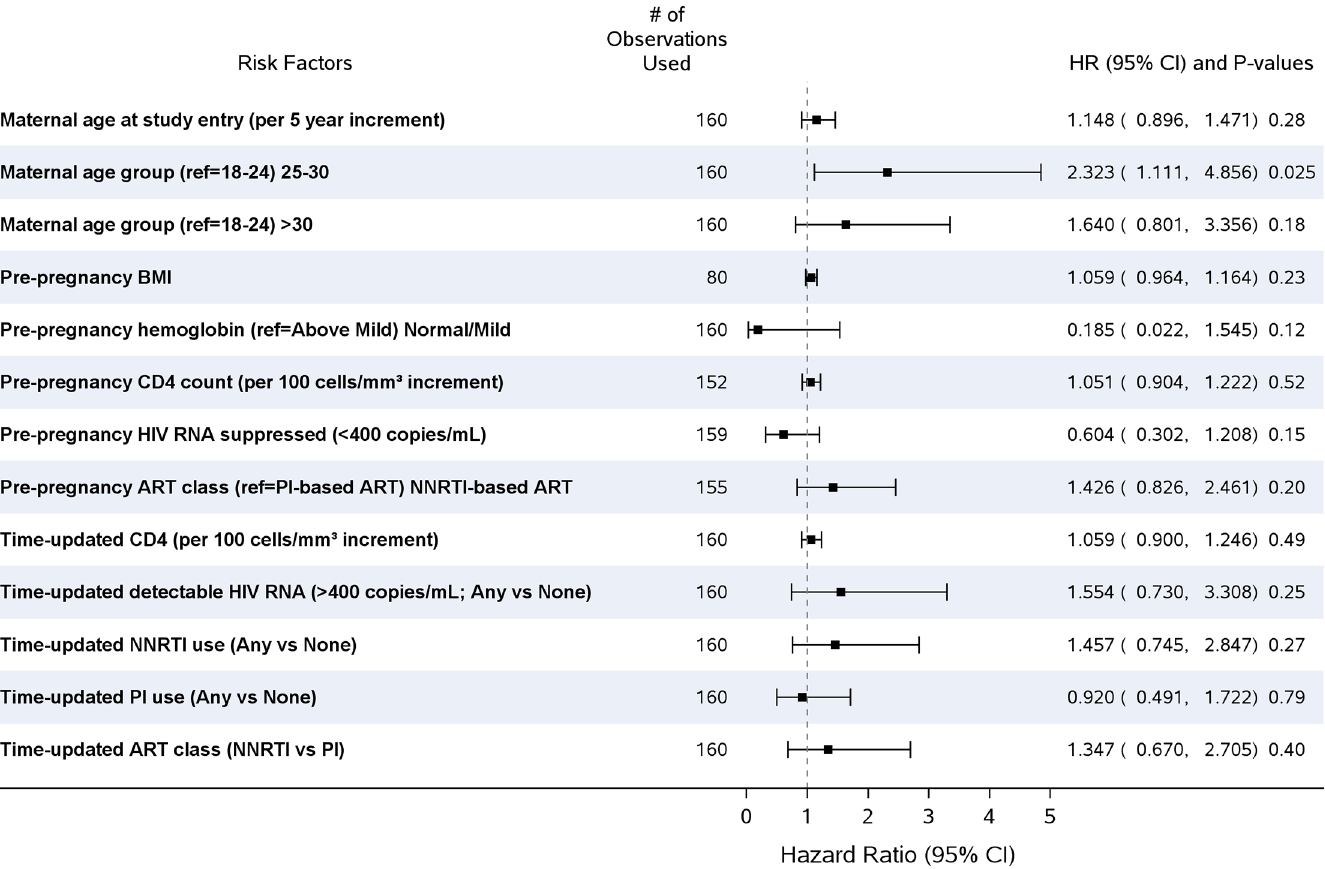
Fig 2. Cox proportional hazard models of time to preterm live birth pregnancy outcomes (adjusted for region and parent study).